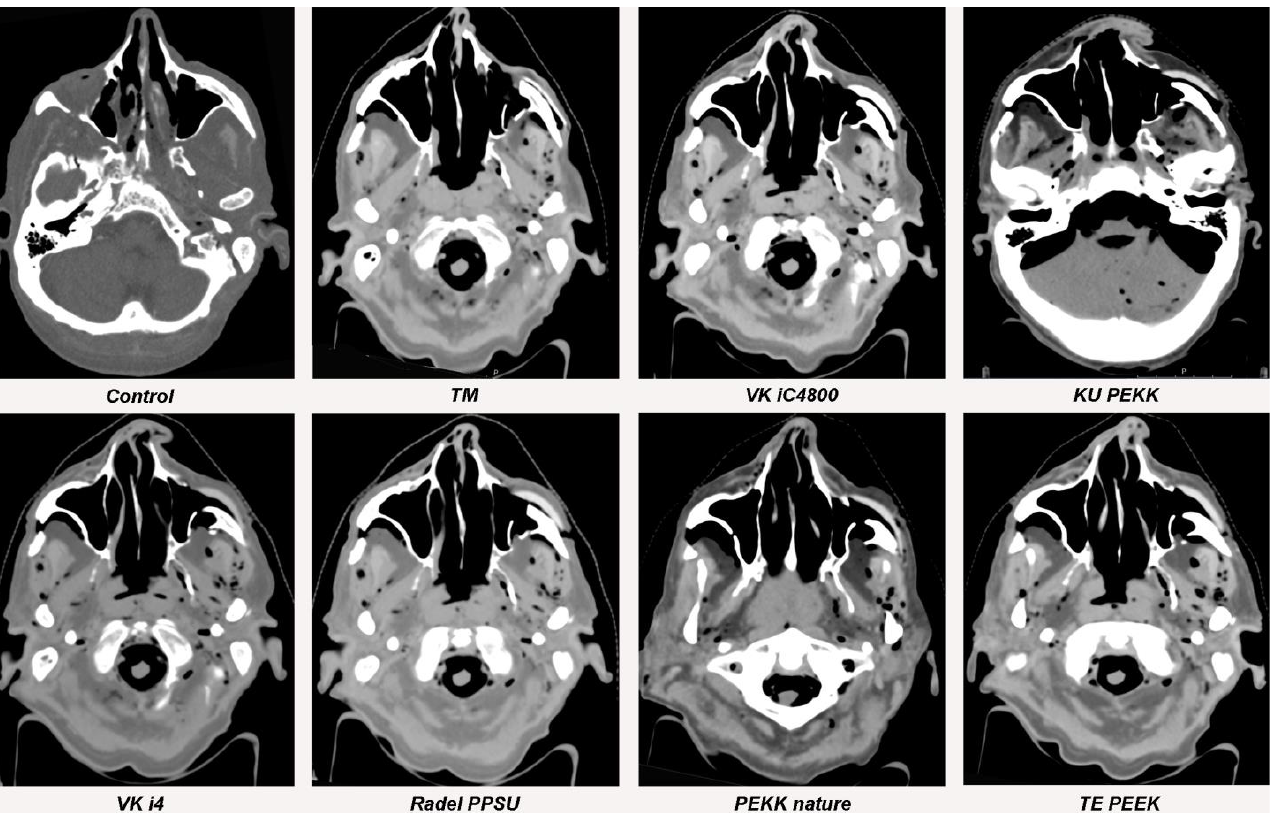
Figure 5. Streak artifacts of TM, VK iC4800, KU PEKK, VK i4, Radel PPSU, PEKK nature and TE PEEK in CT images in axial orientation versus control. Artifacts of each implant were measured at three different anatomical landmarks: (1) the zygomatic soft tissue, (2) the temporal muscle and (3) the parotid gland.